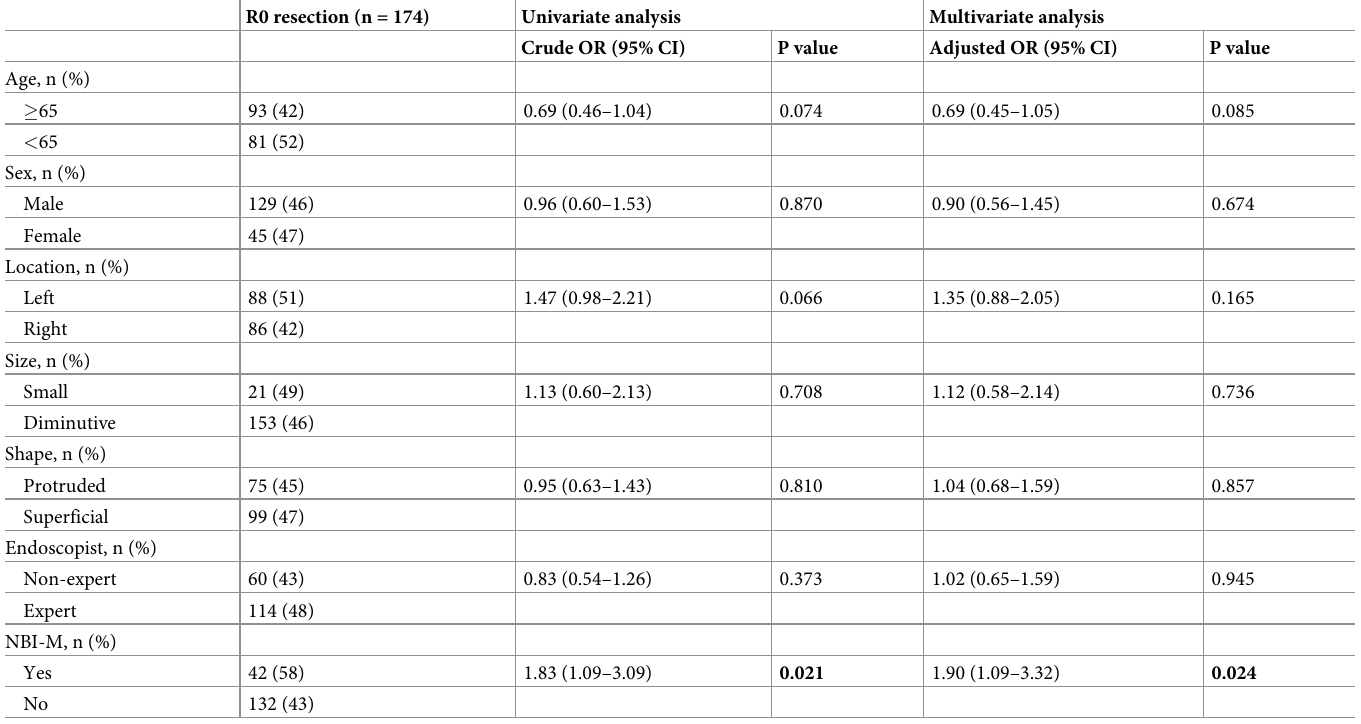
Table 4. Predictive factors for R0 resection (n =